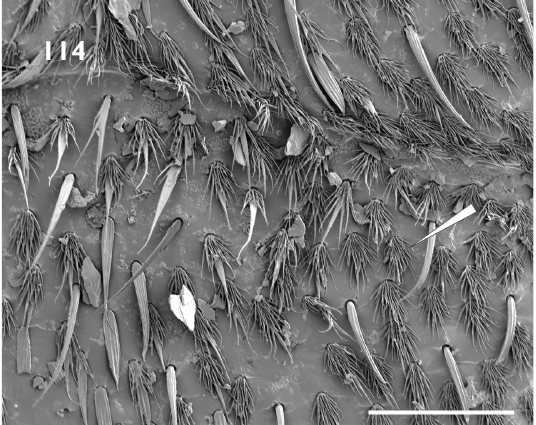
Figure 114. SEM photograph of Austromonticola furcatus abdominal ventrite 2 showing pappolepidia (arrowed). Scale bar = 0.1